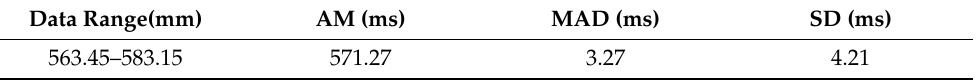
Figure 19. Execution times and distribution of data in time – performance evaluation experiments . Table 2. Summary of evaluation items and experimental results of temporal performance .